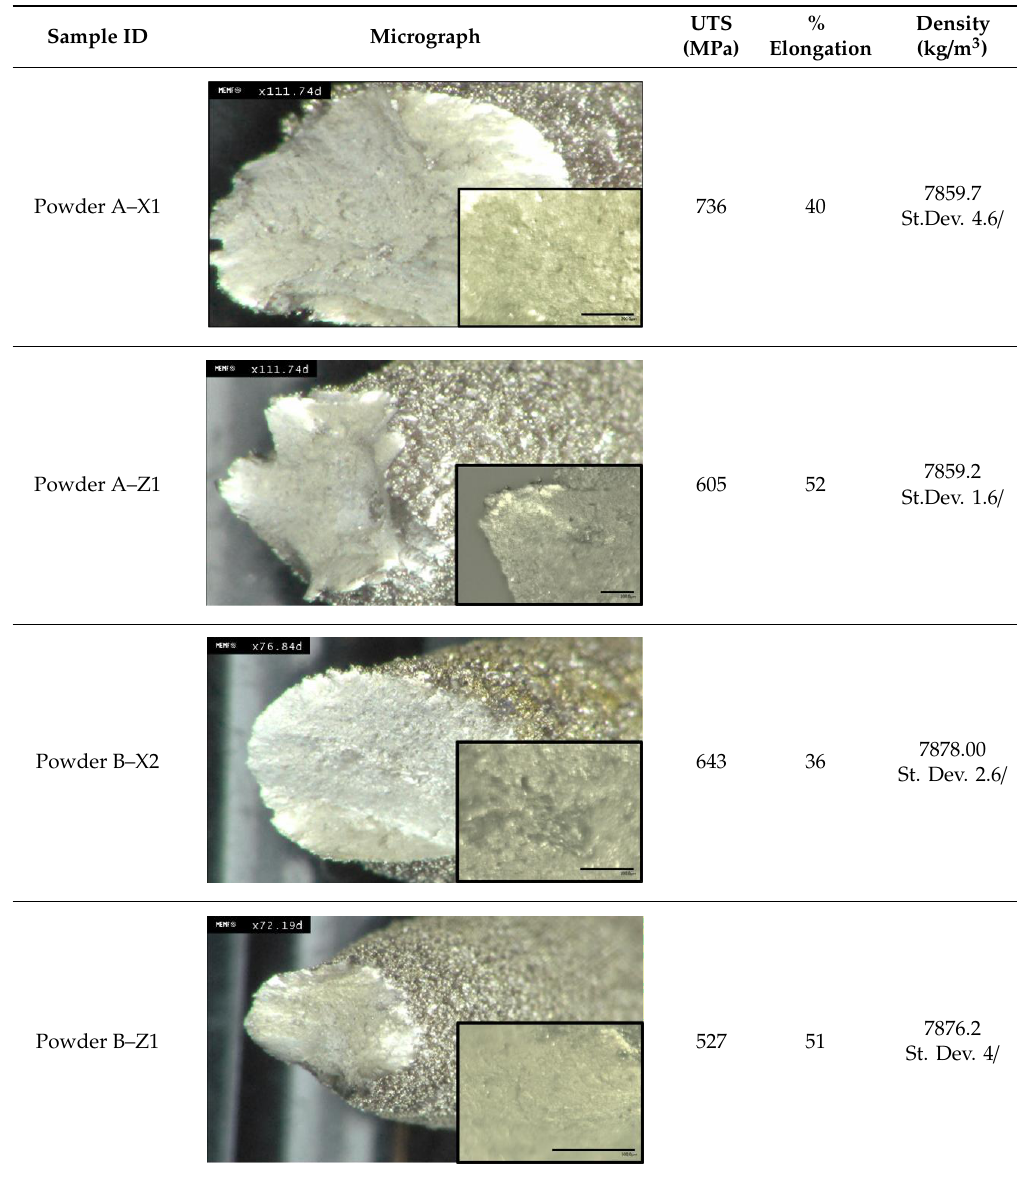
Table 8. Micrographs of tensile sample fracture surfaces. Scale bars for inset images are 200 µm for Powder A–X1 and Z1, Powder B–X2 and 500 µm for Powder B–Z1. Density values calculated using